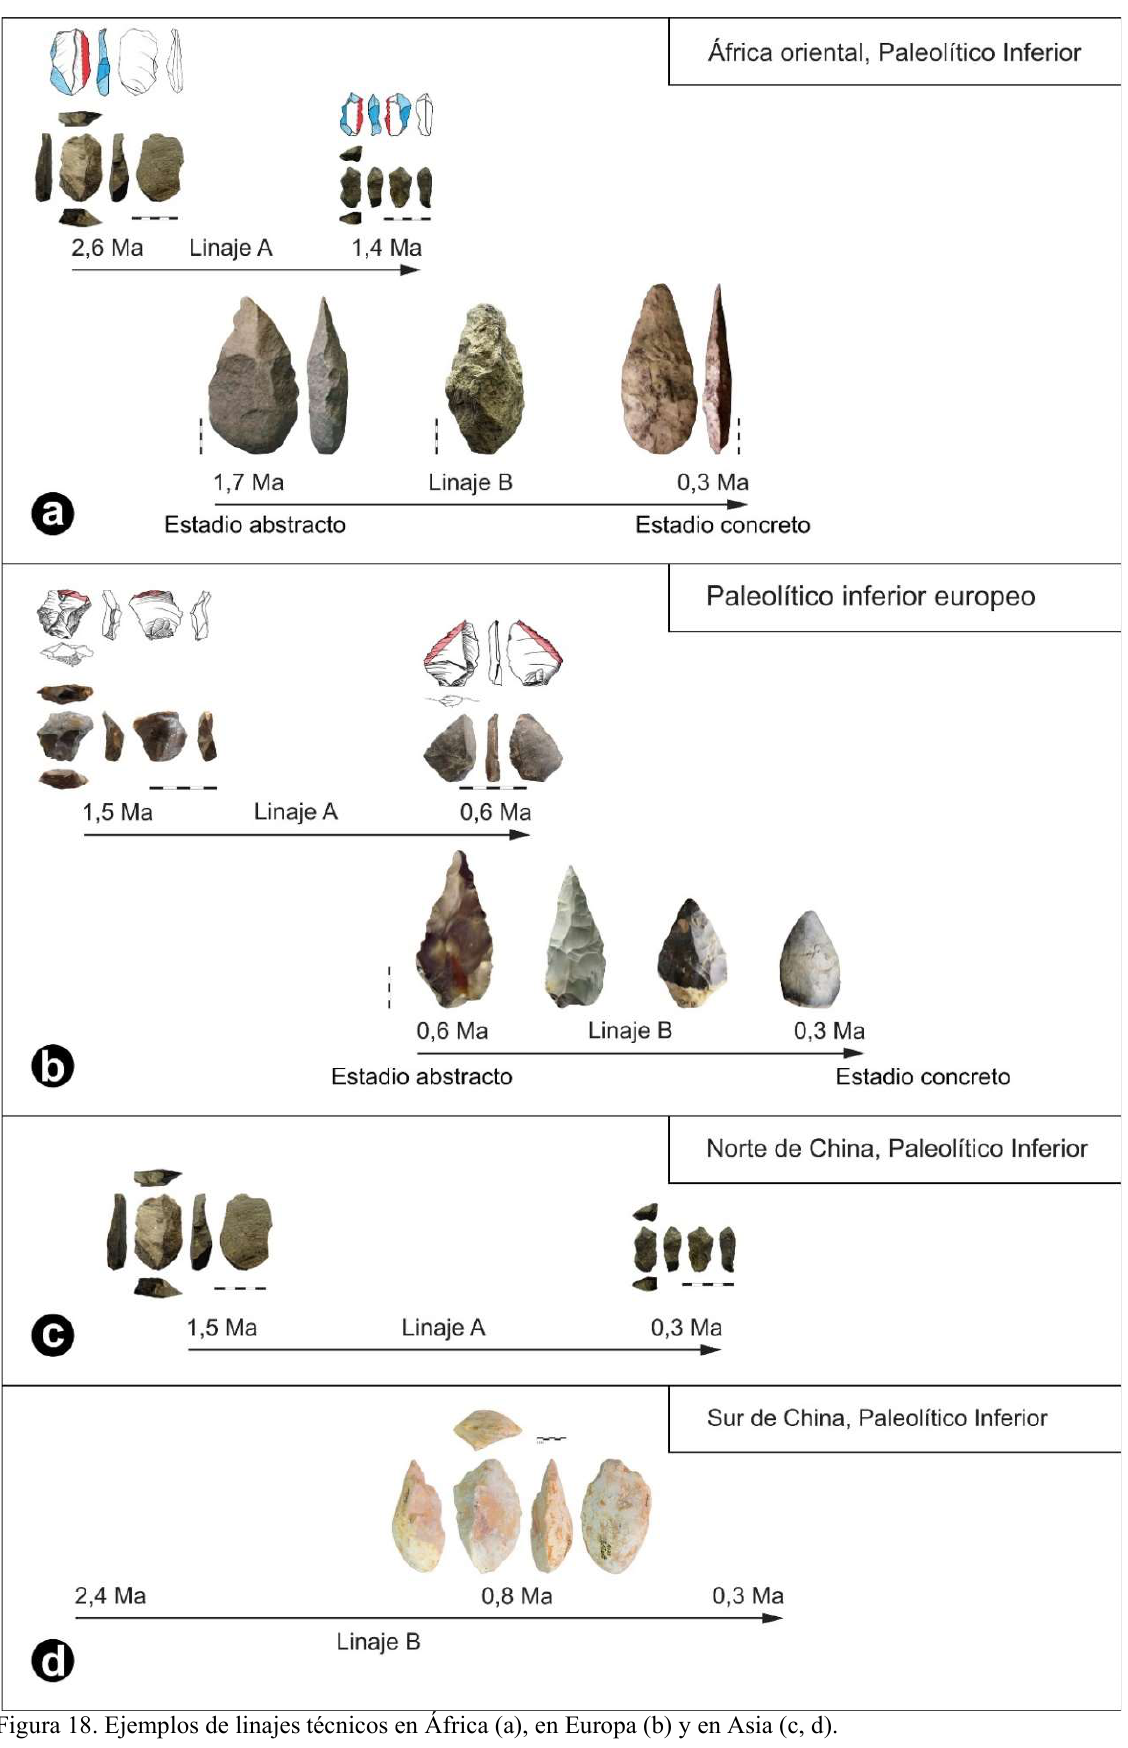
Figura 18. Ejemplos de linajes técnicos en África (a), en Europa (b) y en Asia (c,